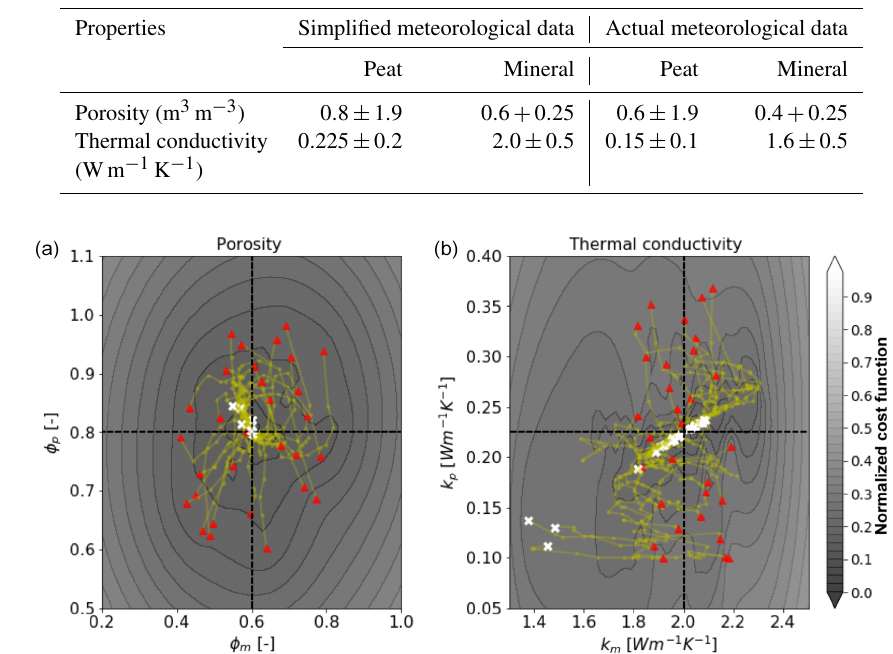
that the number of samples that one needs to run to ensure the robust convergence of the estimated parameters depends on the specifics of the corresponding case (i.e., experiment- specific). If most of the LM runs converge to the same set of parameters and have low cost function values, then that set of runs most likely corresponds to the actual { φ,k } . In Fig. 4, the red triangles represent initial guesses (parameter combinations), and the synthetic truth is indicated by the in- tersection of the two dotted lines. Yellow lines connecting red triangles with white crosses represent the path that the LM algorithm has taken from the initial guess to the estimated parameter combination (white crosses, Fig. 4). The yellow dots along the yellow lines indicate the location at each LM iteration. Figure 4 indicates that the method is able to recover porosities more robustly than thermal conductivities, i.e., es- timated porosities are similar to their true state. According to the liquid saturation plot in Fig. 3, liquid saturation of the mineral layer is quite dynamic and more saturated in compar- ison to the peat layer. Nevertheless, thermal conductivity of the mineral layer ( k m ) corresponds to the highest mismatch. Three out of 30 inversions corresponding to k m end up